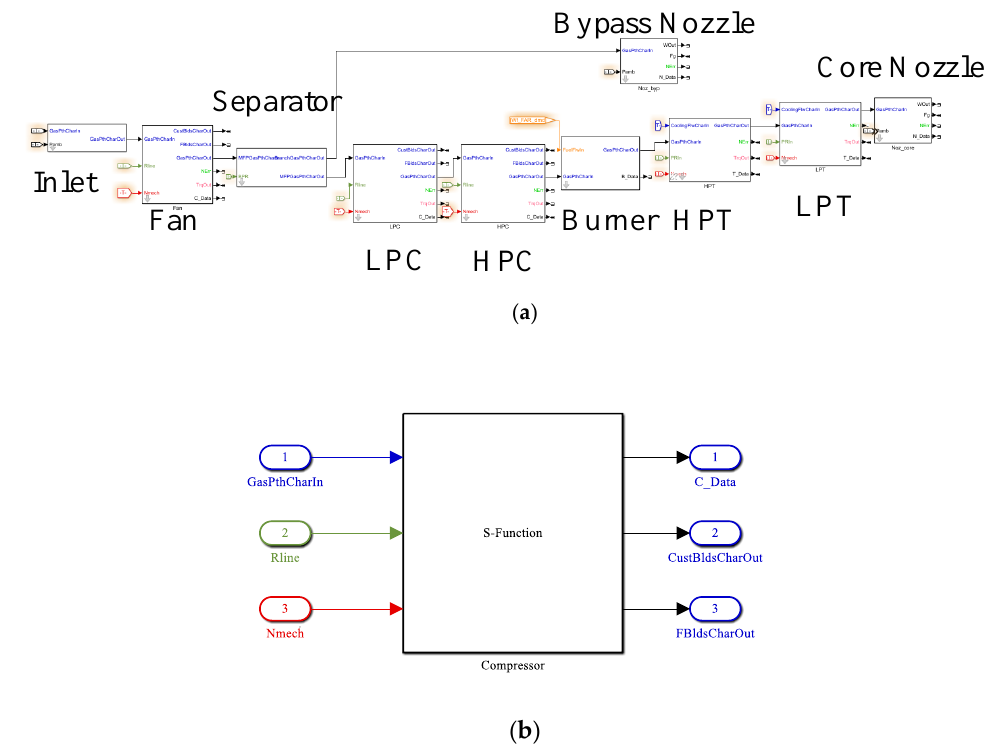
Figure 15. ( a ) JT9D engine model using C/Simulink. ( b ) JT9D compressor model using C/Simulink.